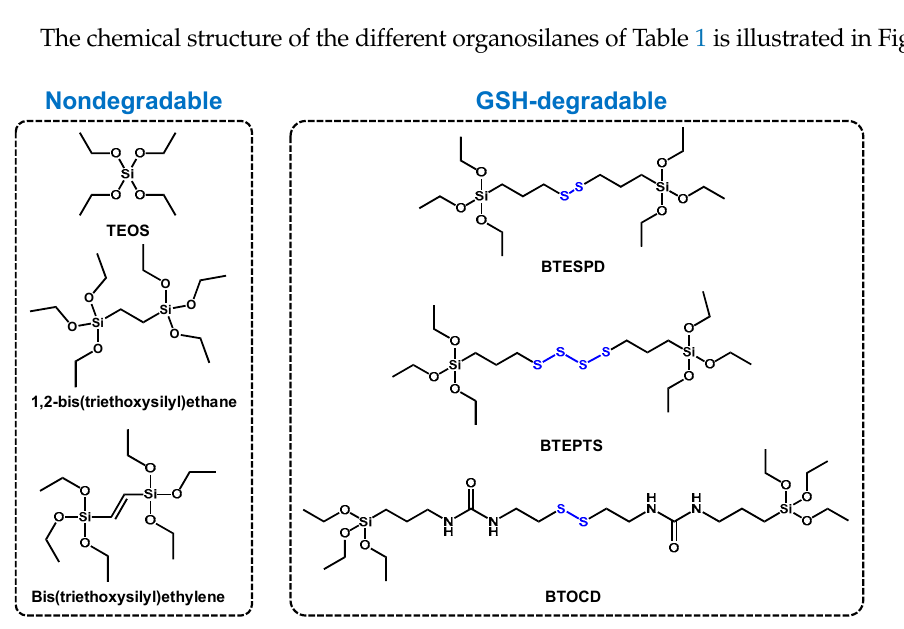
Figure 10. Representative example of the biodegradation by GSH of bridged (here denoted as MONs) vs. conventional MSNs. The different NPs were incubated in SBF solution in the presence or absence of 10 mM of GSH. As observed, conventional MSNs were nearly unaffected after 7 days, irrespective of the presence of GSH, whereas those containing disulfide bonds broke into tiny frag- ments in the reductive environment. Reproduced with permission from [63]. Copyright Elsevier, 2018. As observed in Figure 10, the incubation of the different NPs with SBF in the presence or absence of GSH led to completely different degradation behaviors. Conventional MSNs maintained their overall structure after 7 days. However, disulfide-bridged MSNs de- picted first signs of degradation even after 24 h, to further decompose into small fragments after a week. As a general trend, the different articles that have been analyzed for this section show a mean dissolution time of 7–15 days. However, we have also found that many authors tend to focus on the biodegradability of the NPs alone. In our opinion, the focus should be placed on the complete system, as it is known that the surface functional- ization delays the degradation of silica-based nanoparticles [70]. Despite being a relatively new field (to the best of our knowledge the first paper on GSH-responsive, bridged silica-based NPs was published in 2014 [71]), there are already available some advanced biological applications of this kind of NPs.